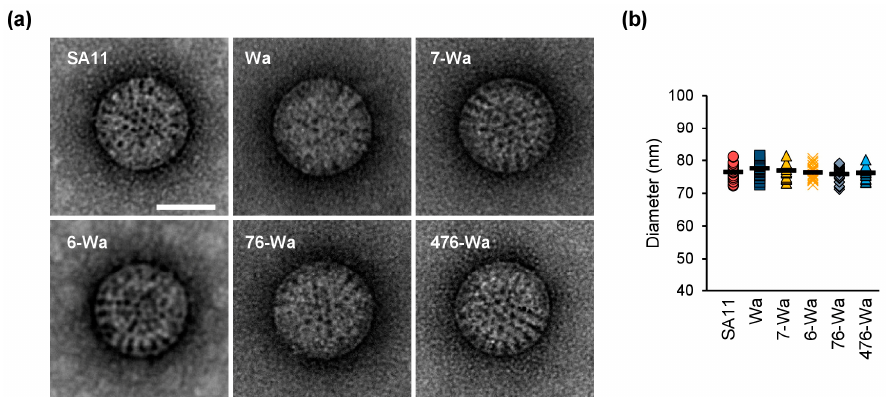
Figure 3. Transmission electron microscopy (TEM) analyses of the generated reassortants and their parent viruses. ( a ) TEM images of negatively stained samples. Scale bar = 50 nm. ( b ) Measurement of triple-layered particle size based on TEM images of negatively stained samples. Abbreviations: 4 = VP4; 7 = VP7; 6 = VP6.